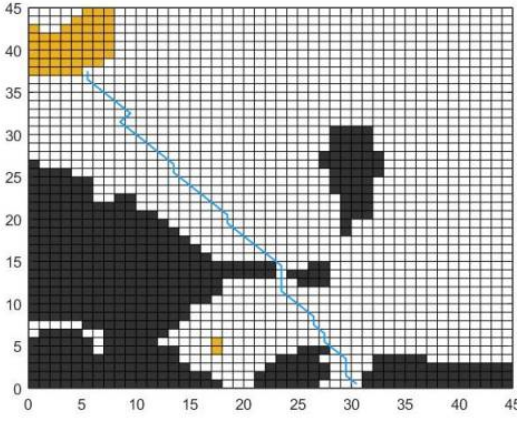
Figure 7. The result of company C.